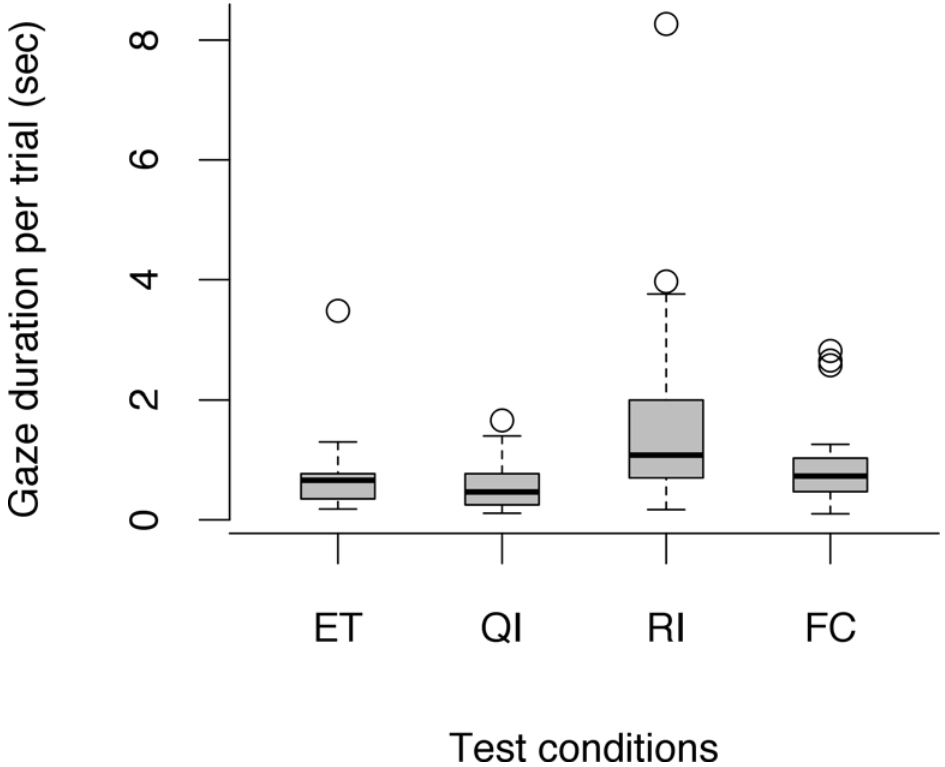
Fig 4. Average gaze duration to partner per trial across social test conditions. Circles show outliers, black bars indicate median values, whiskers display upper and lower hinge, and boxes show the interquartile